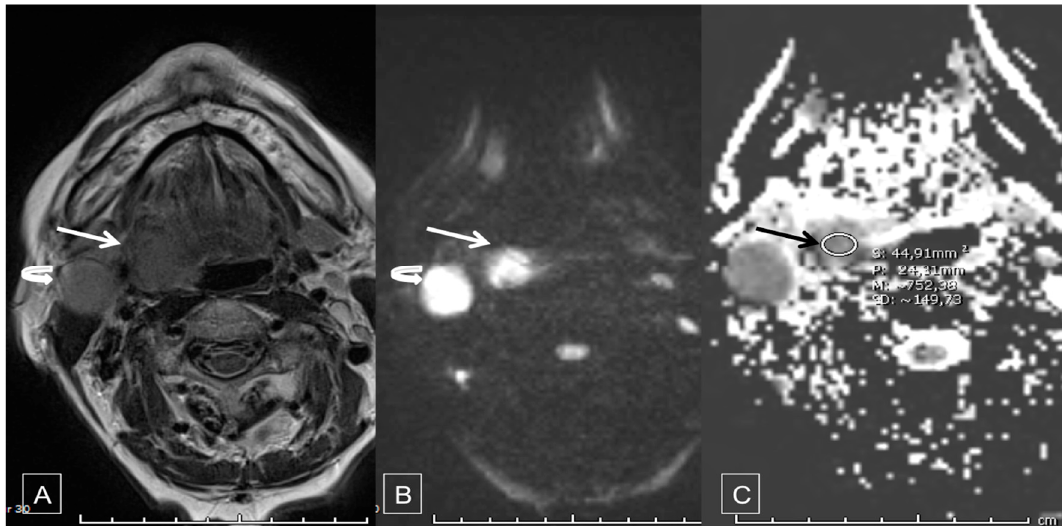
Figure 1. 75-year-old female patient before treatment: ( A ) Axial T2, ( B ) high b-value (b = 1000), diffusion-weighted Magnetic Resonnance (MR) images show a 2 cm large lesion on the right tonsil extending anteriorly to the posterior border of the base of the tongue (arrow), along with a 2 cm large adenopathy in the II B area (curved arrow). These lesions exhibit markedly high signal intensity in image ( B ). ( C ) Apparent diffusion coefficient (ADC) map show restriction of diffusion in both the lymph node and the lesion, with a mean value of the ADC of 0.75 s/mm 2 .